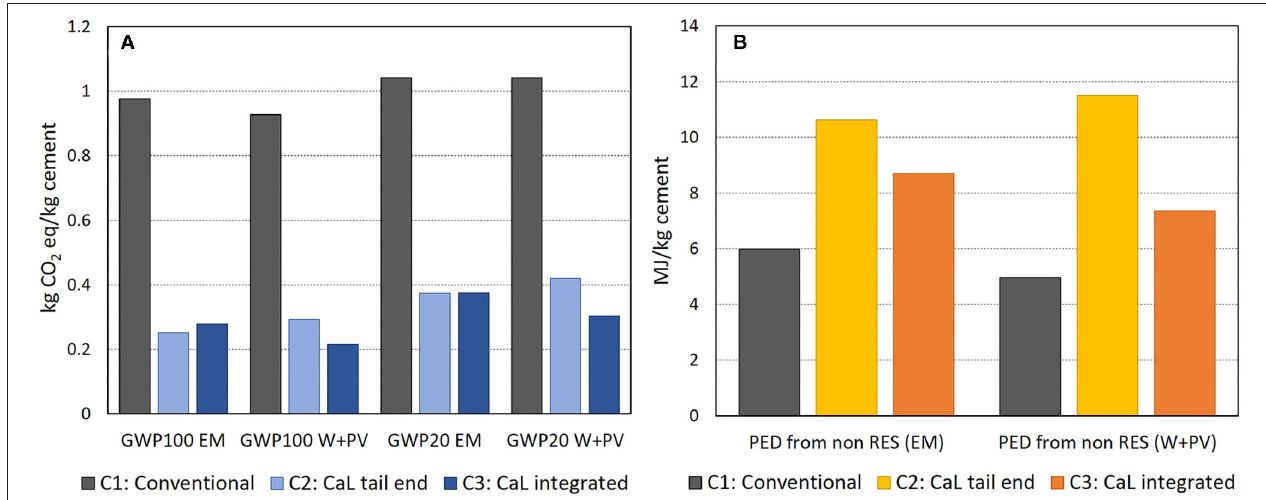
FIGURE 7 | Sensitivity analysis. (A) GWP100 and GWP20 of the systems analyzed per kg of cement produced related to the scenario of the present (Ecoinvent, 2020 ) electricity production mix (EM) and to a scenario dominated by renewable energy resources (RES), i.e., 50% wind and 50% photovoltaics (W + PV). (B) Primary energy demand (PED) from non-renewables resources (non-RES) related to the same two different scenarios, i.e., EM and W +